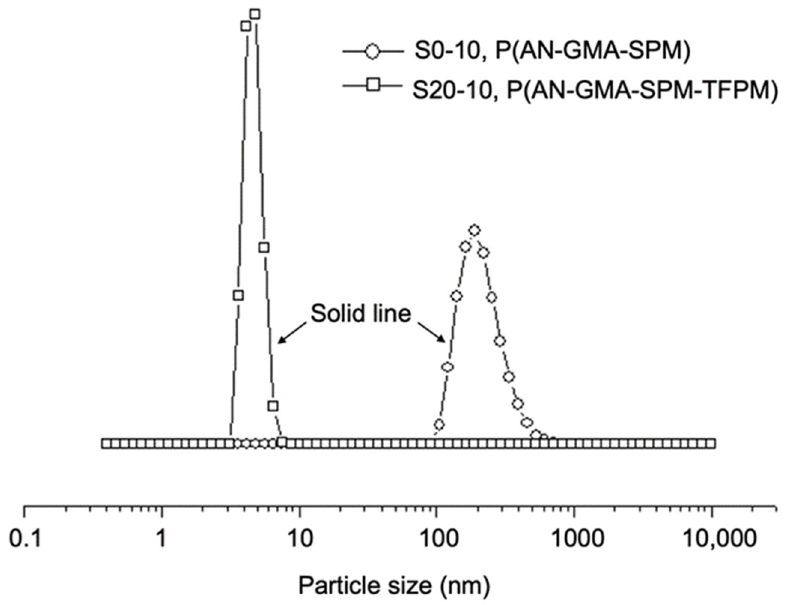
Figure 4. Size distribution of random ionomer aggregates formed in aqueous solution. The solid line is the Gaussian fit.